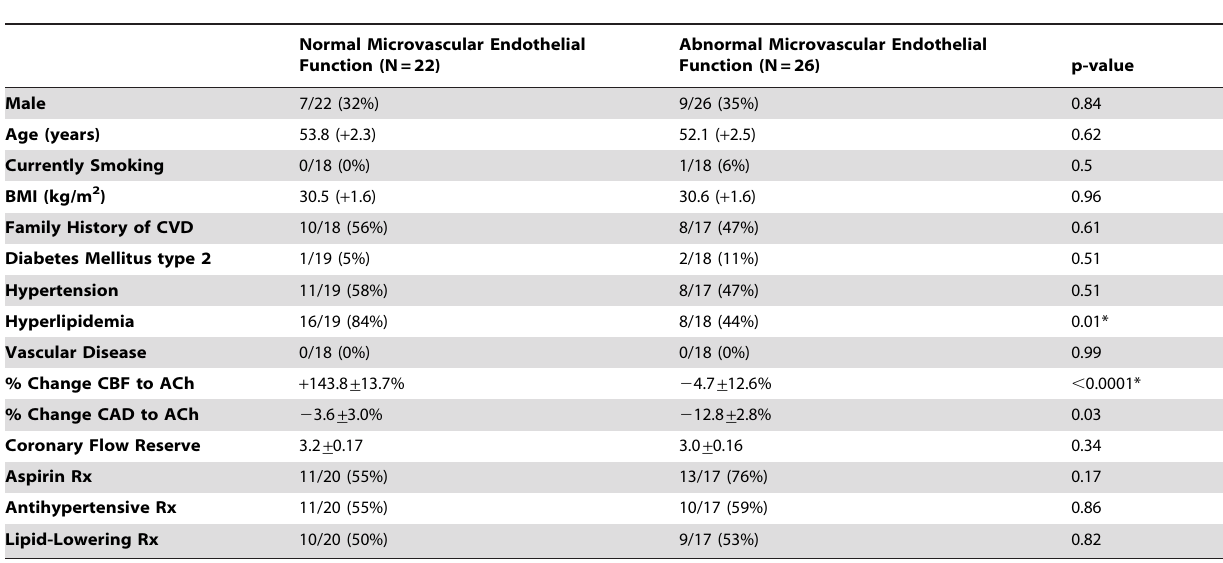
Table 1. Baseline characteristics of participants divided into groups based on microvascular endothelial function.